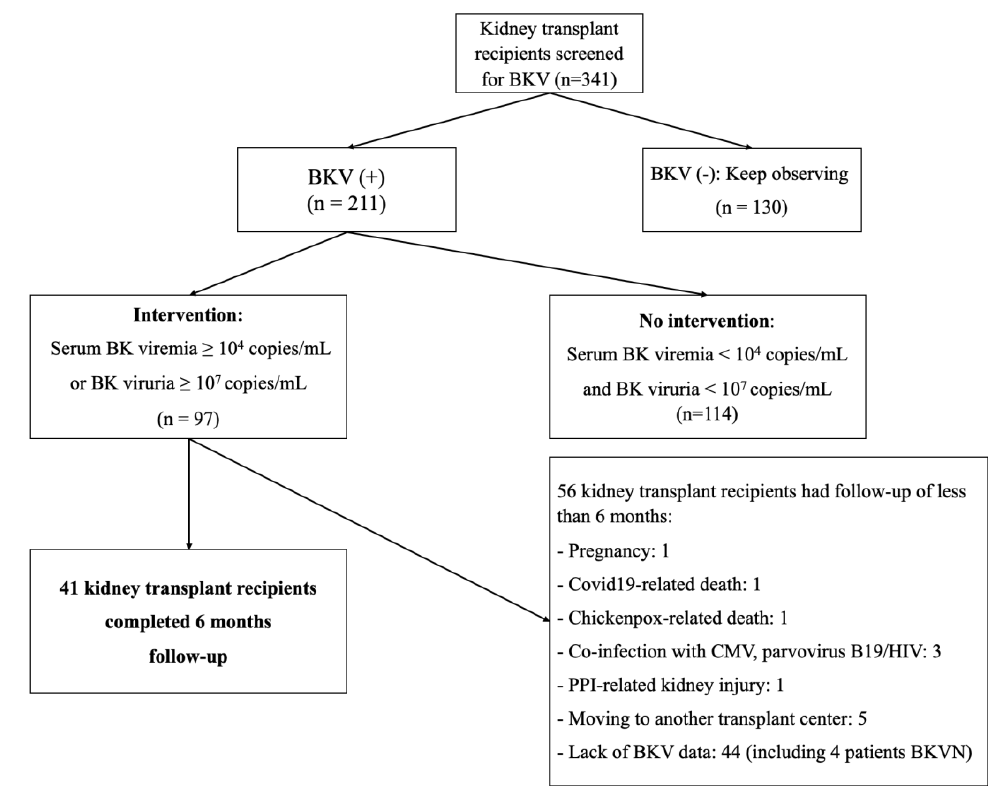
Figure 1. Study flow chart. Abbreviations: CMV, cytomegalovirus; HIV, human immunodeficiency virus; PPI, proton pump inhibitor.